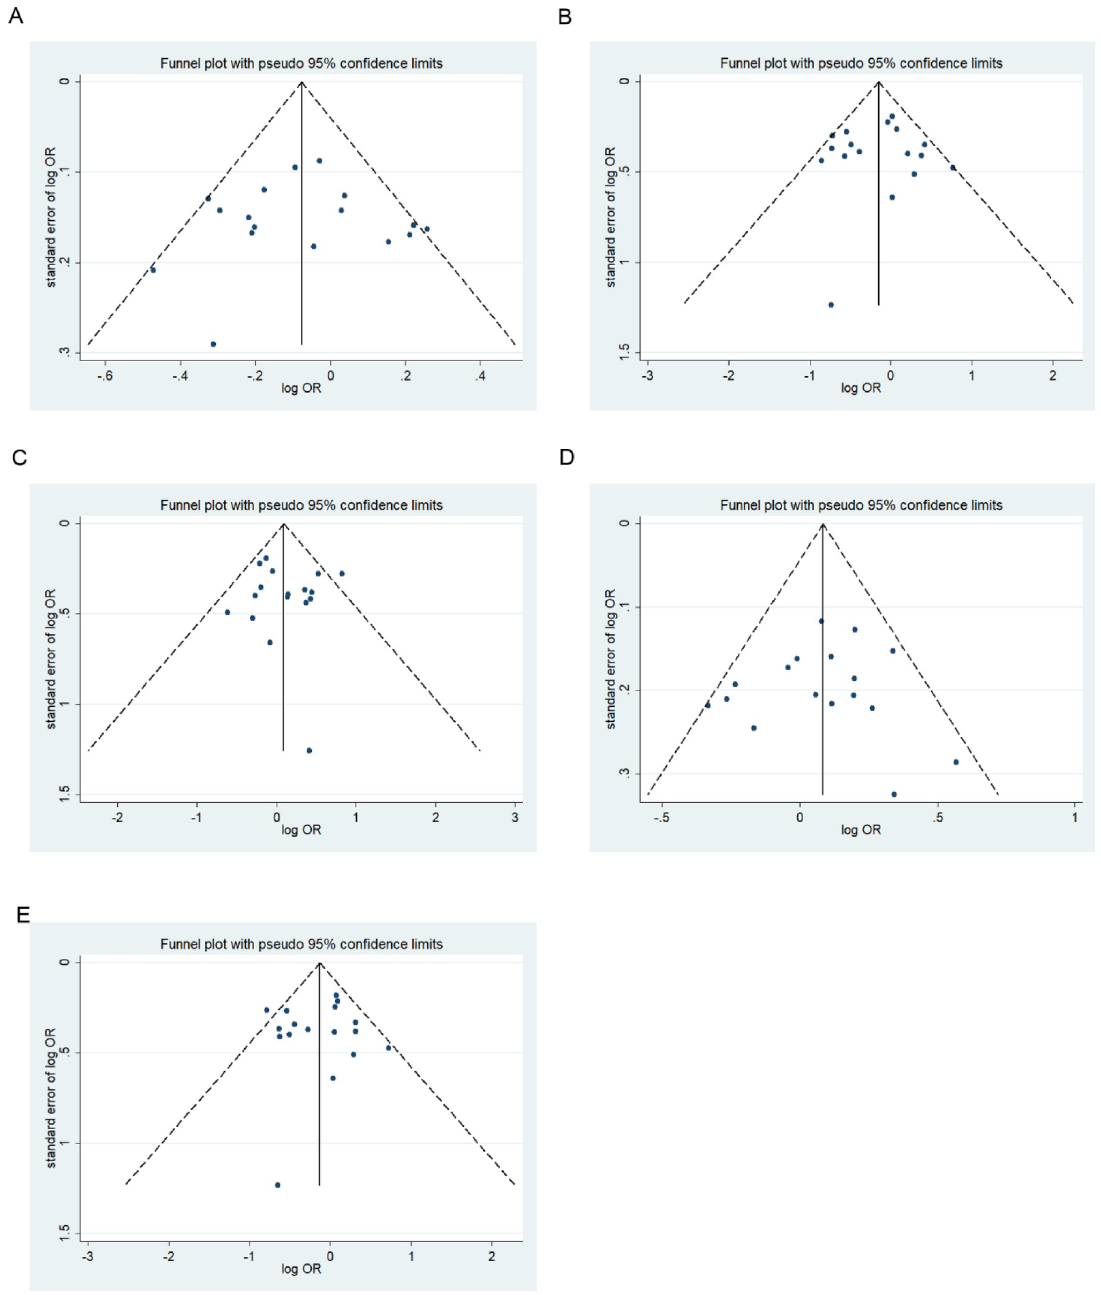
Fig 13. Funnel plot analysis depicting publication bias in the association between MTHFR 1298A > C polymorphism and schizophrenia in the five genetic models (A, allele contrast; B, homozygous codominant; C, heterozygous codominant; D, dominant; and E,